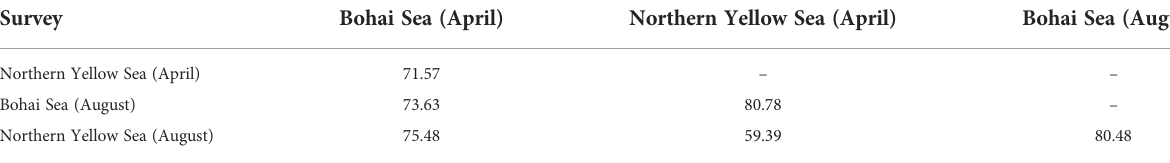
TABLE 2 Average macrobenthic community dissimilarity (%) off Yantai, China, based on four surveys, in April and August of 2020. Survey